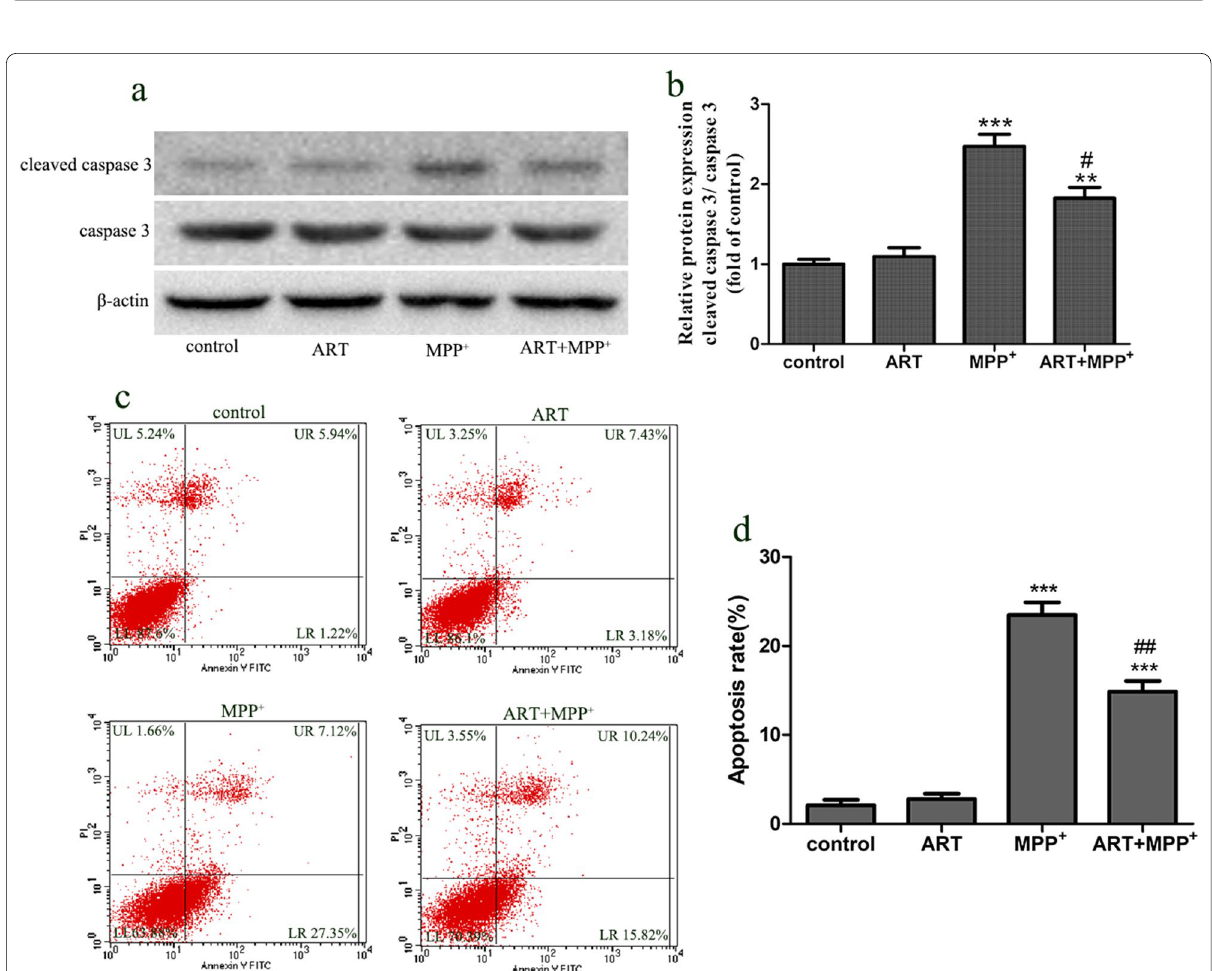
Fig. 4 ART reduced the MPP + -induced apoptosis in SH-SY5Y cells. The protein expression of caspase-3 and cleaved caspase-3 was detected by Western blotting, and β-actin was used as an equal loading control ( a , b ). Flow cytometry was used to detect cell apoptosis after double staining with annexin V-FITC and PI ( c , d ). The data are presented as the mean